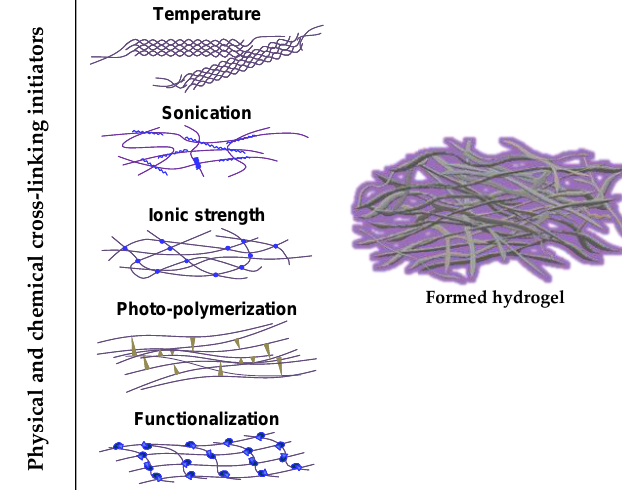
Figure 2. Hydrogel-based biomaterials for brain repair. ( A ) Chemical structure of the more frequent biomaterials and their constituent monomers used in neurorestorative therapies. ( B ) Hydrogel polymerization can be induced by physical and chemical cross-linking. Representative cross-linking initiators are temperature, electric/magnetic fields, ultraviolet exposition (photopolymerization), sonication, pH, ionic strength, solvent composition or functionalization among others. The cerebral implantation of hydrogel polymers (alone or in combination with cells) can be performed using the biomaterial in a formed state (polymerized before brain implantation) or injected as a liquid in the brain (pre-gel) to be formed in situ under physiological conditions. This latter approach reduces the invasiveness of biomaterial implantation allowing the hydrogel to fill amorphous cavities as the result of injury. PLGA: poly(lactic- co -glycolic acid); PEG: Poly(ethyleneglycol); TGP: poly( N -isopropylacrylamide- co - n -butyl methacrylate); TRP: poly( N -isopropyl- acrylamide).